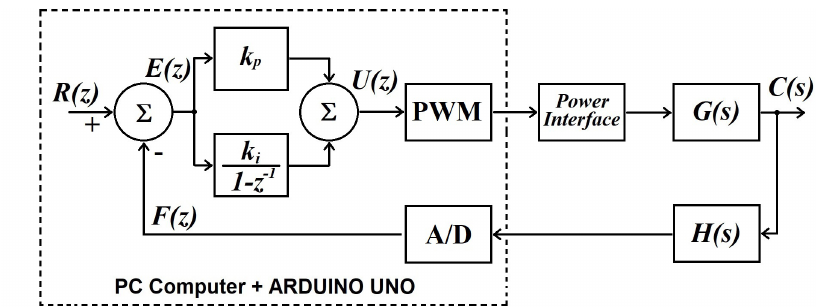
Figure 8. Block diagram representation of the controller’s